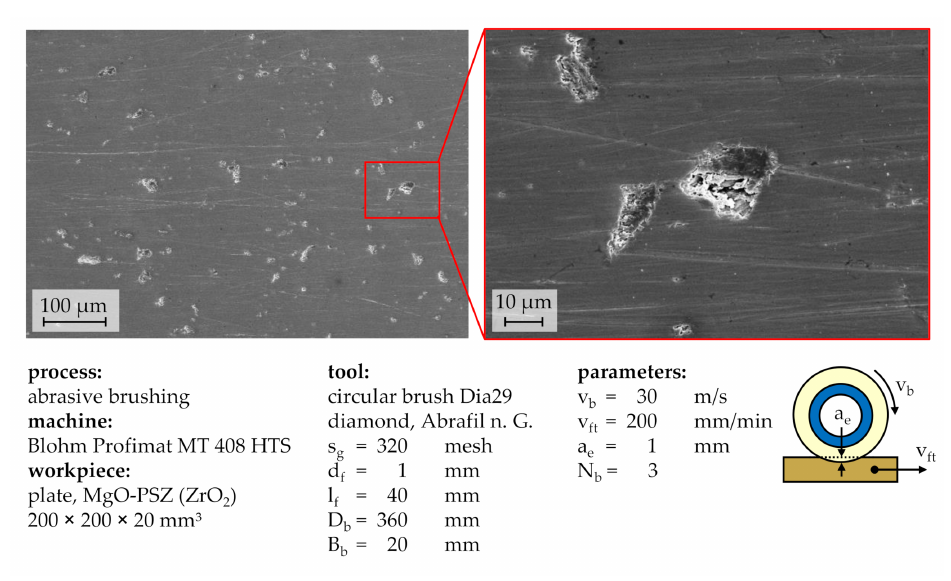
Figure 10. SEM images of ZrO 2 surface, brushed with a brushing velocity of v b = 30 m /